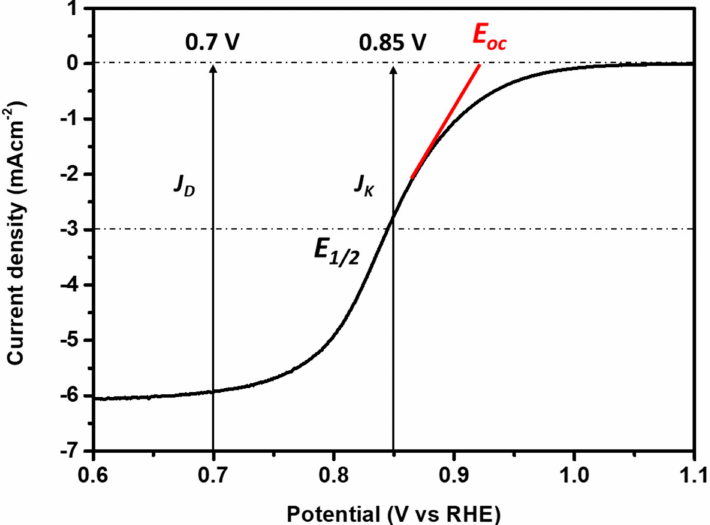
Figure 2. The linear sweep voltammetry curve depicting the onset potential (Eoc) and half-wave potential (E 1 / 2